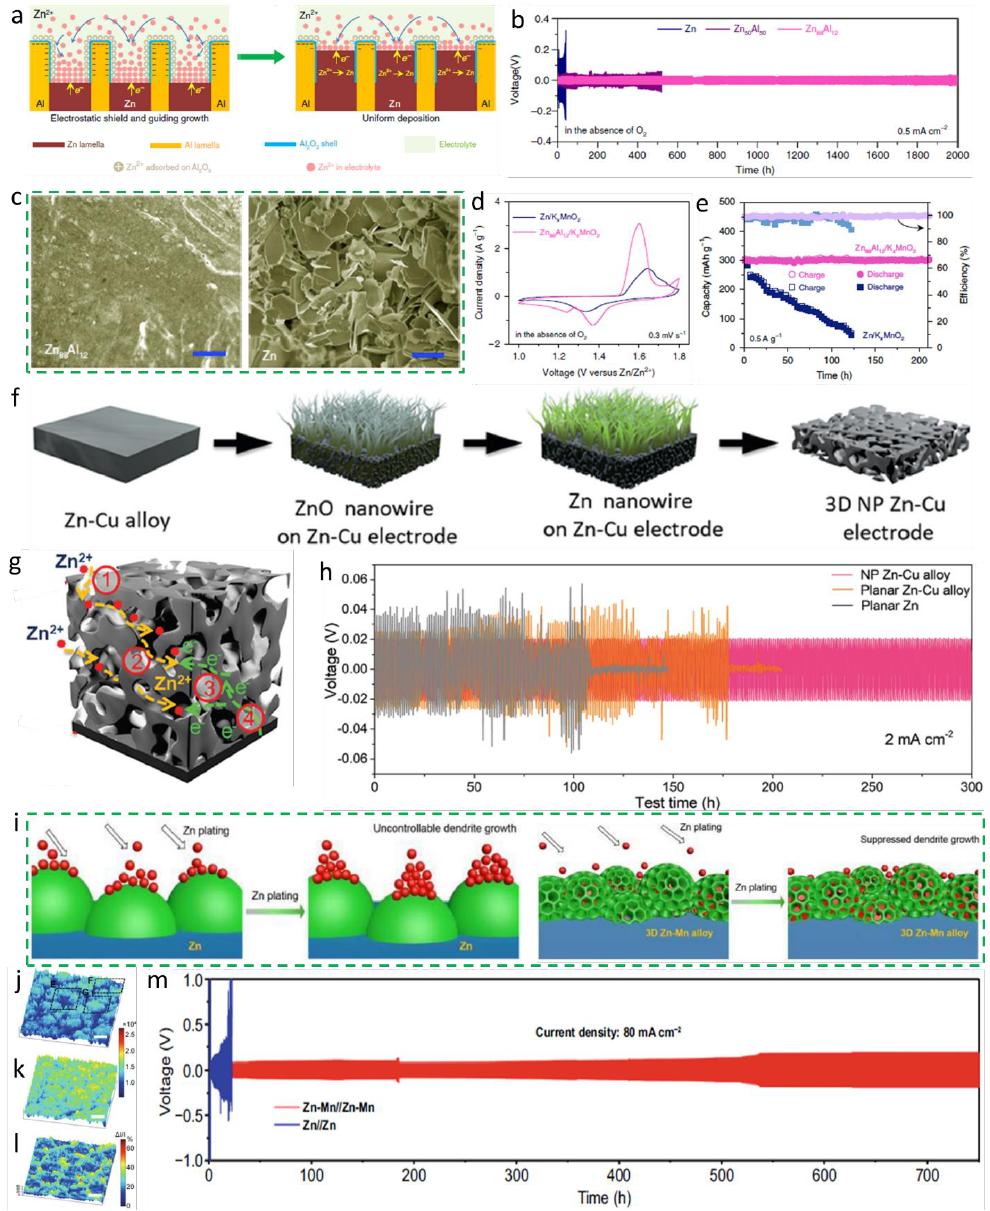
Figure 11. ( a ) Schematic illustration of eutectic strategy for dendrite and crack suppression, ( b ) long-term Zn stripping/plating cycling of the symmetric batteries of bare Zn and Zn/Al alloys, ( c ) SEM images of eutectic Zn 88 Al 12 and bare Zn after long term Zn stripping/plating, ( d ) typical CV curves for Zn 88 Al 12 (cid:107) K x MnO 2 and Zn (cid:107) K x MnO 2 batterie, and ( e ) long-term cycling performance of the Zn 88 Al 12 /K x MnO 2 battery at 0.5 A g − 1 compared to the Zn/K x MnO 2 battery. (Reproduced with permission [121] Copyright 2020, Springer Nature). ( f ) The fabrication of 3D Zn-Cu alloy electrode, ( g ) the four primary resistances in 3D NP Zn-Cu alloy electrode, and ( h ) charge/discharge profiles of 3D NP Zn-Cu alloy and bare Zn anodes at 2 mA cm − 2 . (Reproduced with permission [124] Copyright 2020, John Wiley & Son). ( i ) Schematic illustration of Zn plating at the bare Zn anode and Zn-Mn anode, ( j , k ) is the surface topography images of 3D Zn-Mn alloy before and after Zn plating, ( l ) the derived image calculated by (k − j)/k = ( ∆ I/I). The experiment was performed at a current density of 80 mA cm − 2 for 320 s, and ( m ) Long-term galvanostatic cycling performance of symmetric Zn-Mn and pristine Zn cells at a current density of 80 mA cm − 2 with a capacity of 16 mAh cm − 2 . (Reproduced with permission [127] Copyright 2021, Springer